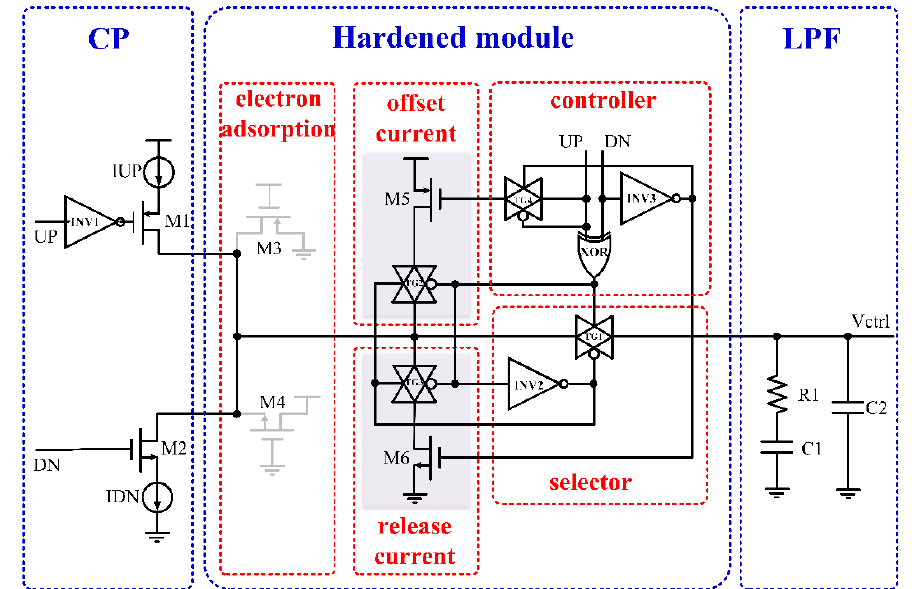
Figure 7. The proposed SET-hardened CP.